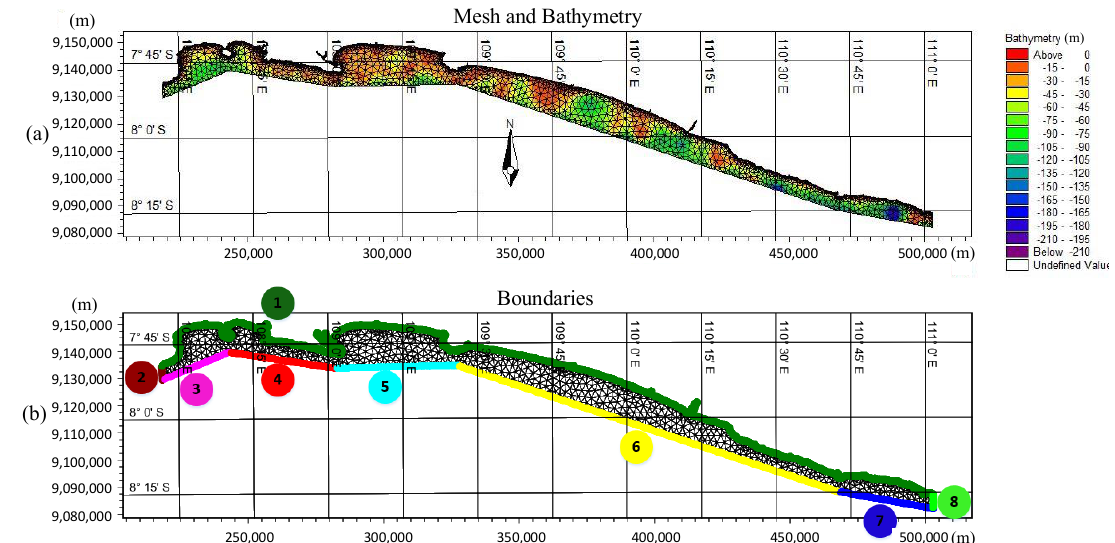
Figure 2. Generated mesh ( a ) and interpolated bathymetry of the simulation domain ( b